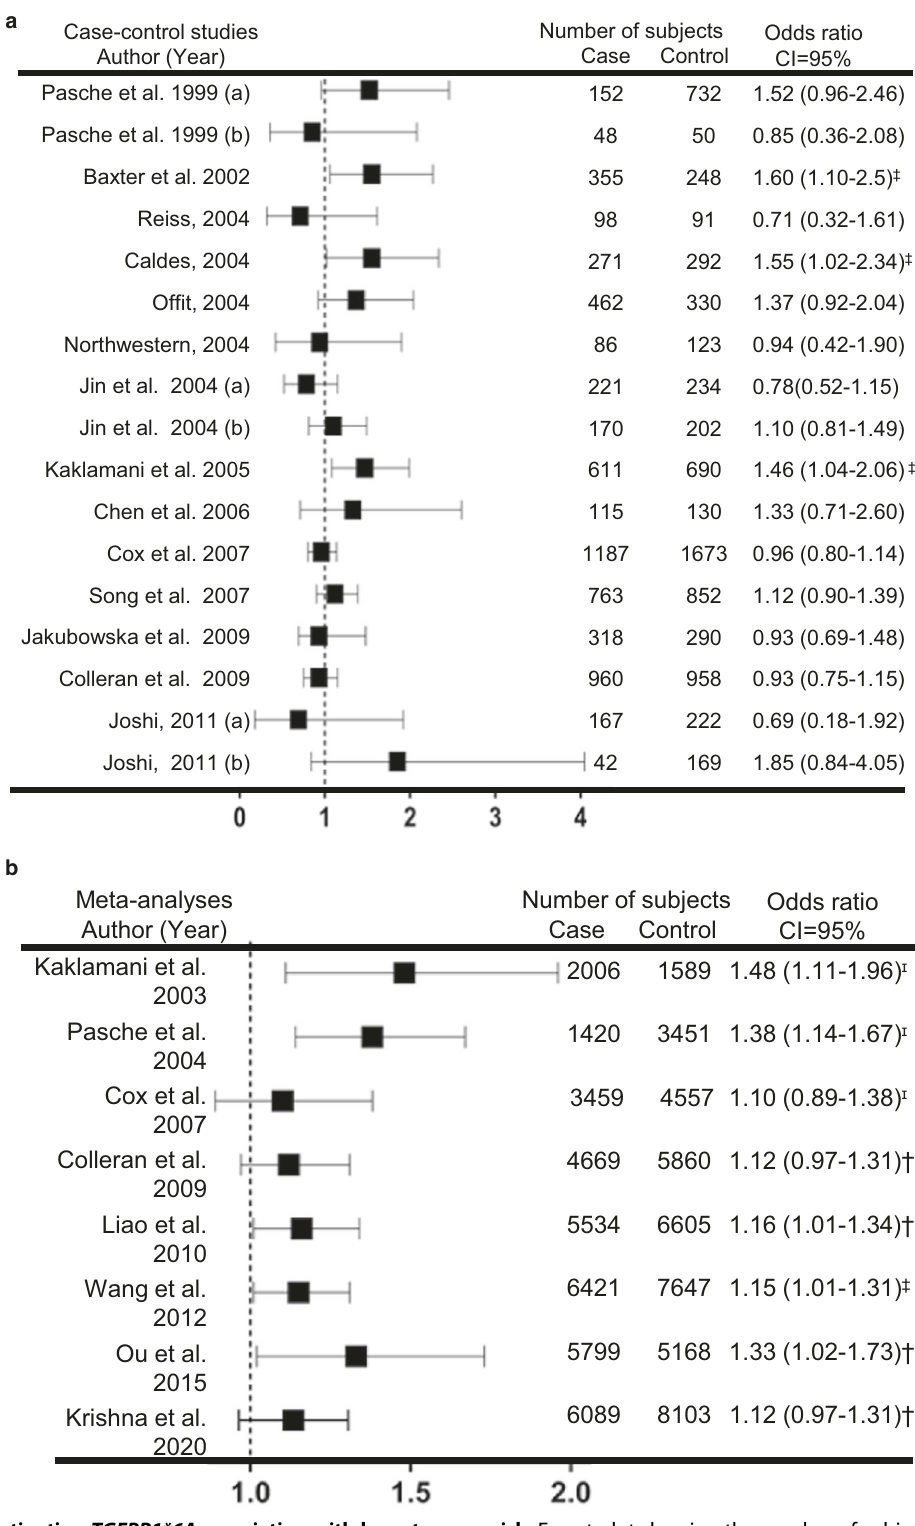
Fig. 2 Studies investigating TGFBR1*6A association with breast cancer risk. Forest plot showing the number of subjects and odds ratios of a Case-control studies, and b Meta-analyses associating TGFBR1*6A to breast cancer risk. Plot a includes only case/control studies that are in Hardy – Weinberg equilibrium. CI con fi dence interval, ɪ dominant association ( p ≤ 0.01), ‡ additive association ( p ≤ 0.05), † allelic association ( p ≤